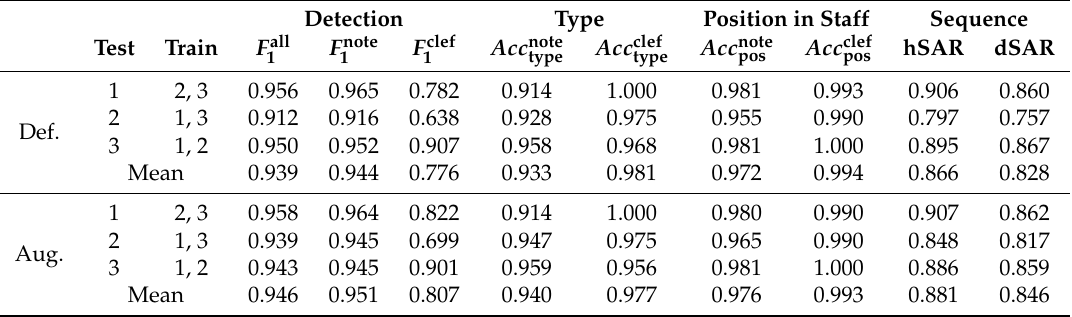
Table 7. Symbol detection scores when testing on one and training on the remaining parts. The upper and lower rows show the results without and with data augmentation, respectively. Padding and a line height of 80px are used for all experiments. Detection Type Position in Staff Sequence